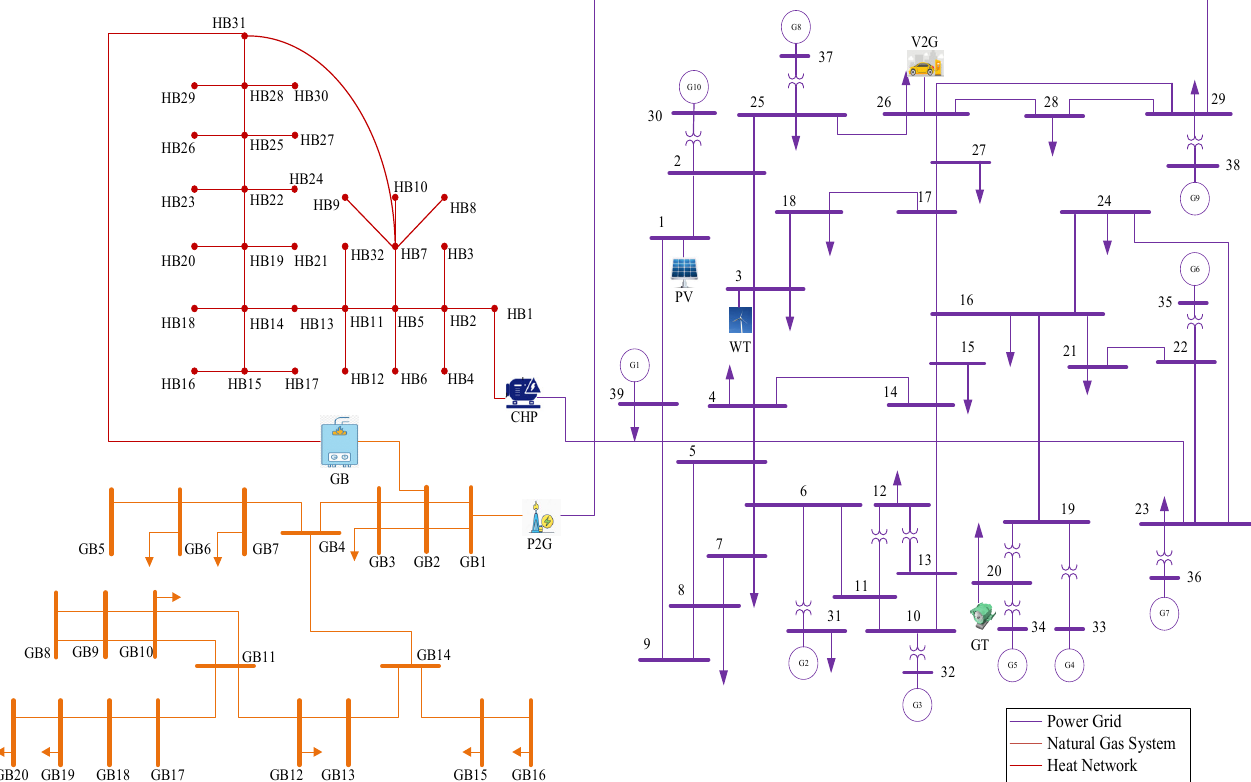
Figure 4. The schematic diagram of the multi-energy system.